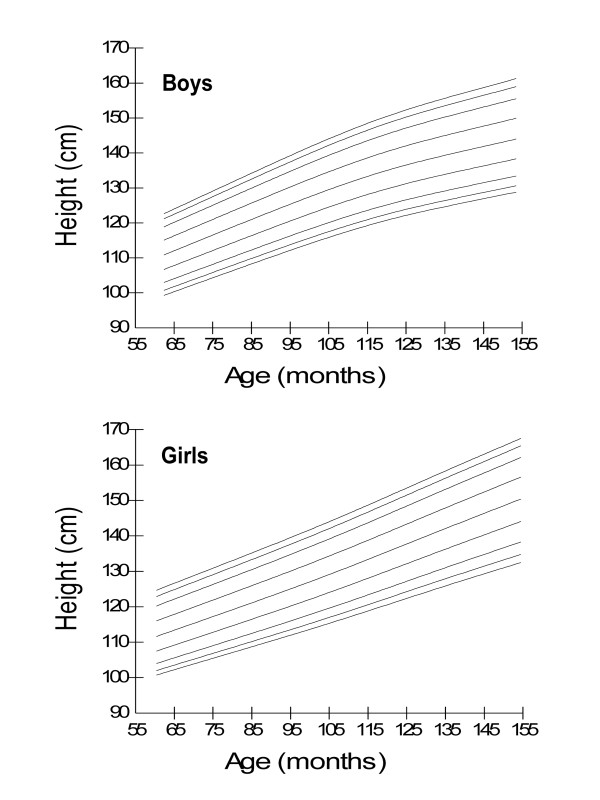
Smoothed height percentile curves for Pakistani primary school boys (n = 997) and girls (n = 883) aged five to twelve years. 5 years (61-71 months), 6 years (72-83 months), 7 years (84-95 months), 8 years (96-107 months), 9 years (108-119 months), 10 years (120-131 months), 11 years (132-143 months) and 12 years (144-155 months).